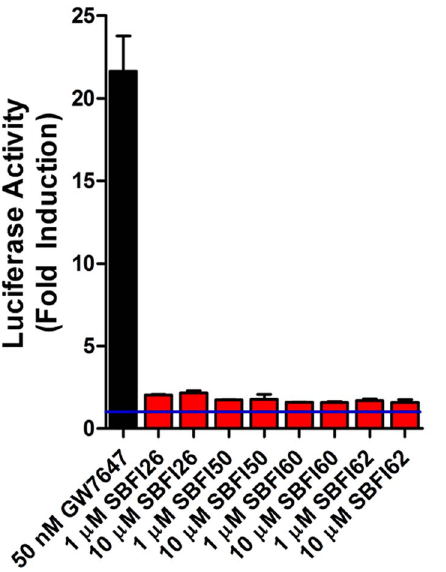
Figure 5. Activation of PPAR a by FABP inhibitors. HeLa cells transfected with a PPAR a reporter were incubated with the indicated compounds for 6 hours and luciferase and b -galactosidase activities were subsequently measured. Luciferase activity was normalized to b - galactosidase. The blue line represents baseline PPAR a activation in the absence of agonists (n=3).